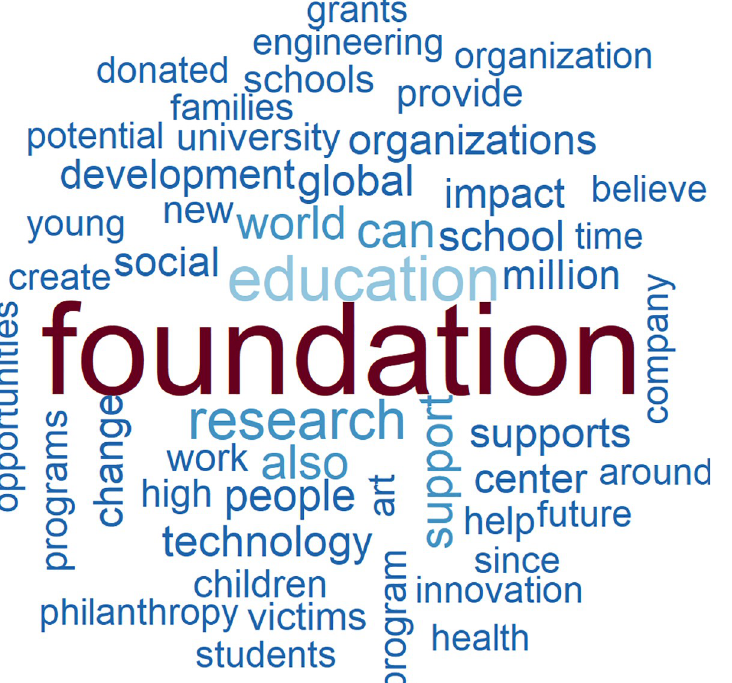
Fig 9. The 50 most frequently used words in the mission statements of the philanthropic foundations of the tech